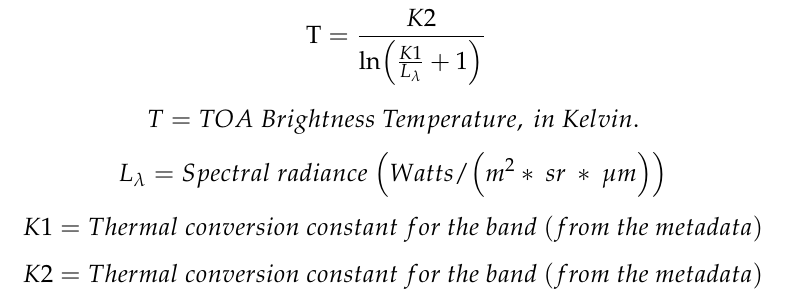
( b ) Figure 4. ( a ) Land use pattern—urban sprawl 2000 and ( b ) land use pattern—urban sprawl 2005.